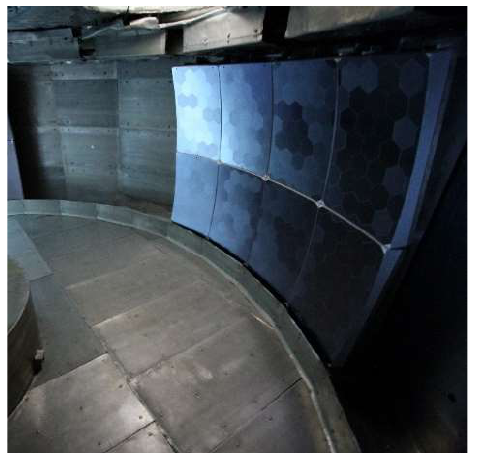
Fig. 2. The photo of the Si311 analyzer mirrors.